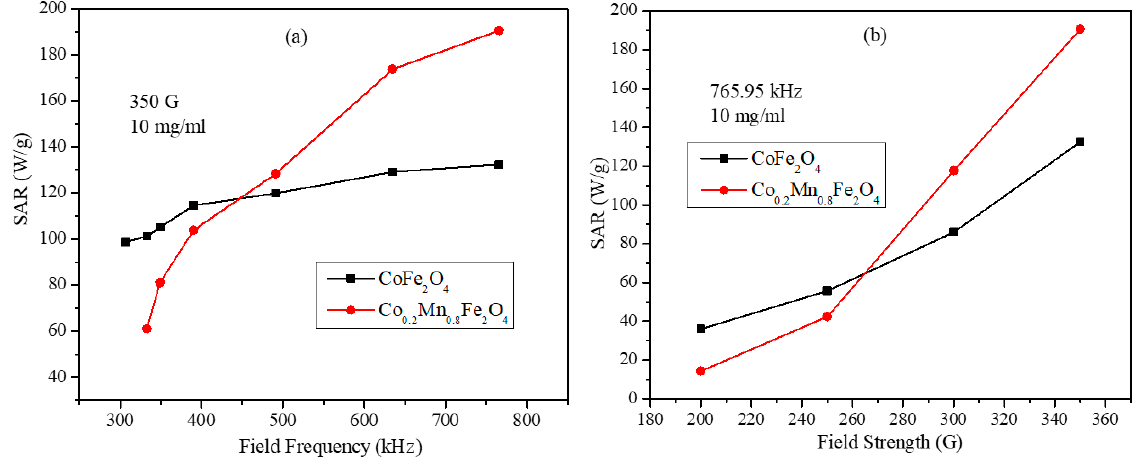
Figure 9. ( a ) SAR values as a function of alternating magnetic field (AMF) frequency at field strength of 350 G for 10 mg/mL of CoFe 2 O 4 and Co 0.2 Mn 0.8 Fe 2 O 4 nanoparticles and ( b ) SAR values as a function of field strength at fixed AMF frequency of 765.95 kHz for 10 mg/mL of CoFe 2 O 4 and Co 0.2 Mn 0.8 Fe 2 O 4 nanoparticles (lines are just guides for the eye).